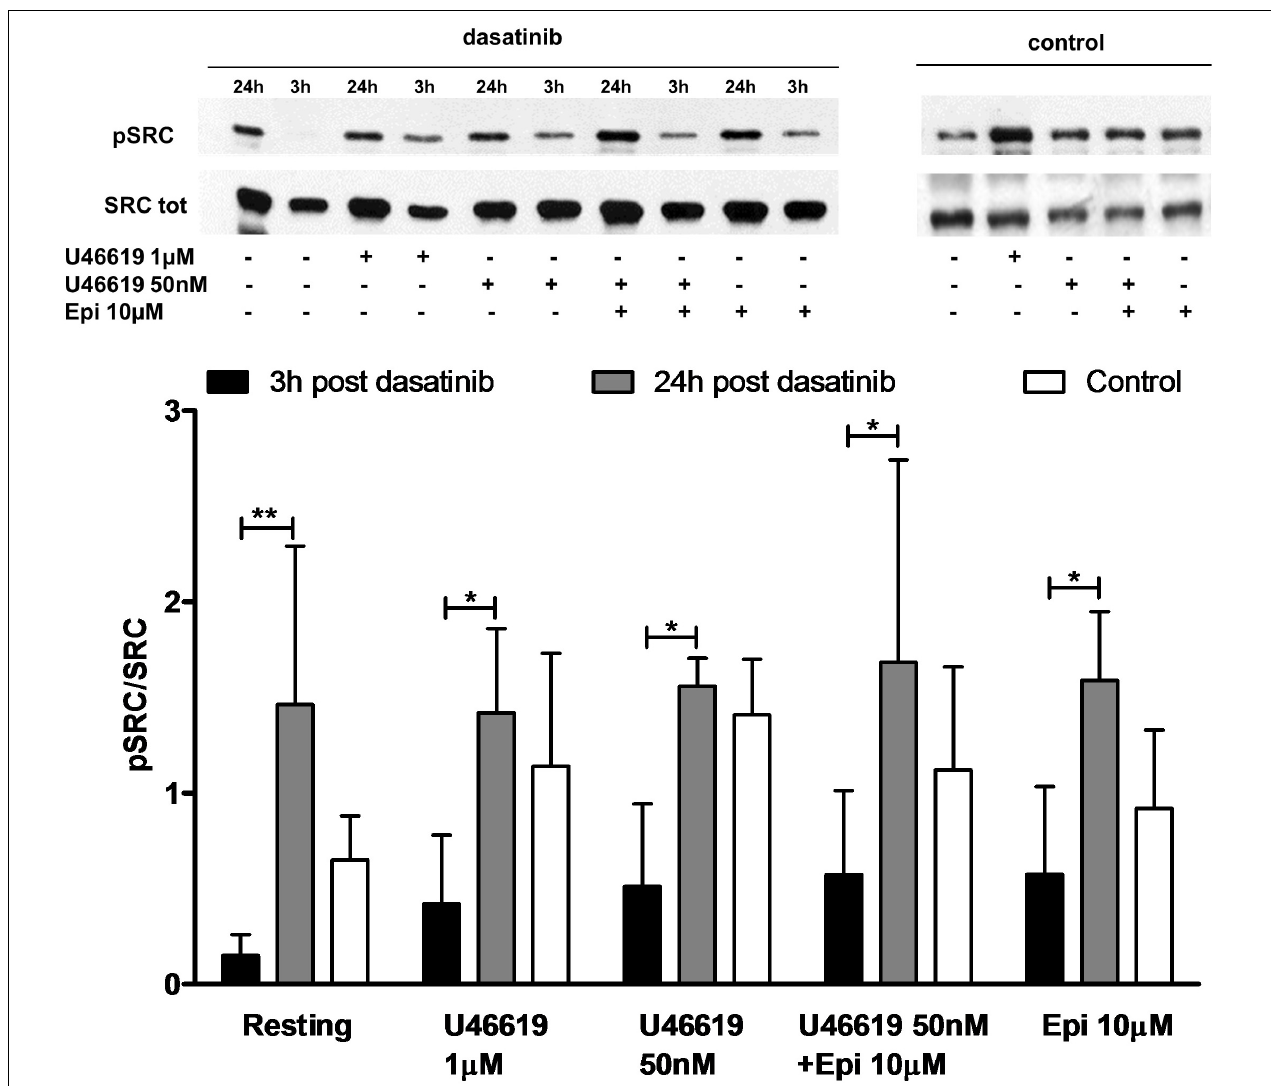
FIGURE 1 | Ex vivo effect of dasatinib on Src phosphorylation. PRP was isolated in the presence of ASA 100 µ M and apyrase VII 10 U mL − 1 from health volunteer ( n = 7) or from patient ( n = 5) 3 and 24 h post treatment with dasatinib. PRP was stimulated by U466191 µ M, U46619 50 nM, epinephrine (epi) 10 µ M,